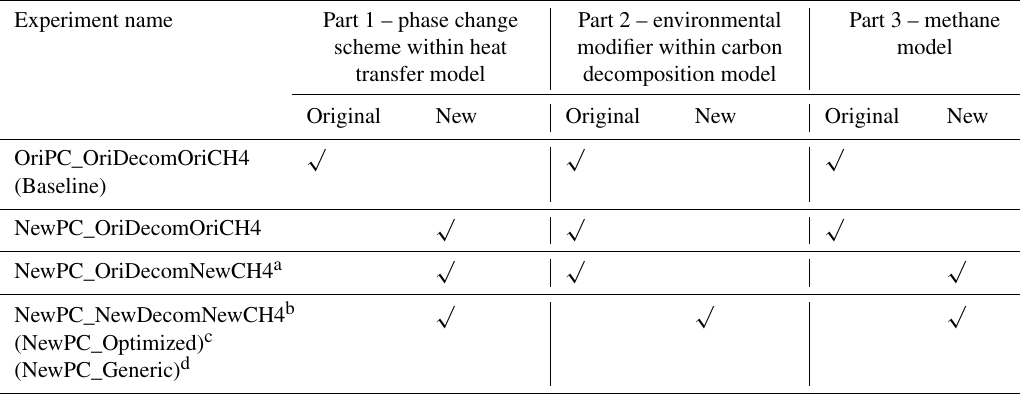
Table 2. List of designed